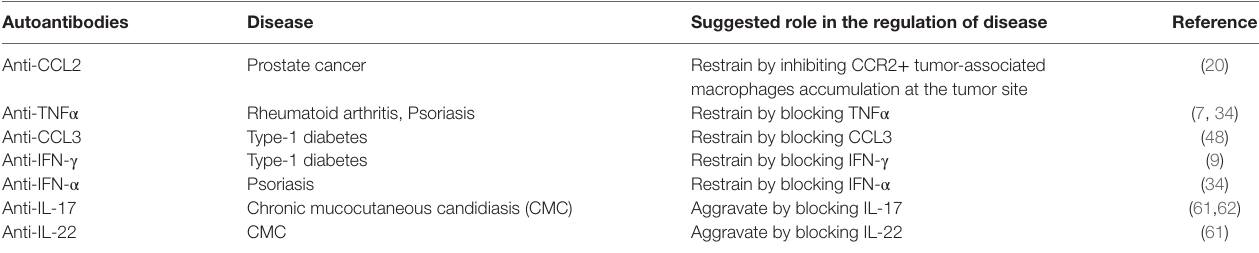
TABLe 1 | The role of autoantibodies to cytokines and chemokines in the pathogenesis of autoimmune, cancer, and infectious diseases. Autoantibodies Disease Suggested role in the regulation of